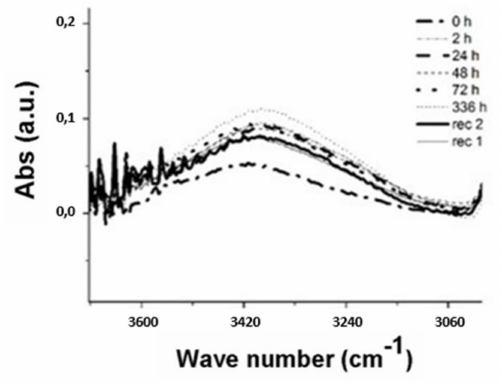
Figure 9. IR spectrum of the -OH signal for samples coated by Silomur at di ff erent ageing